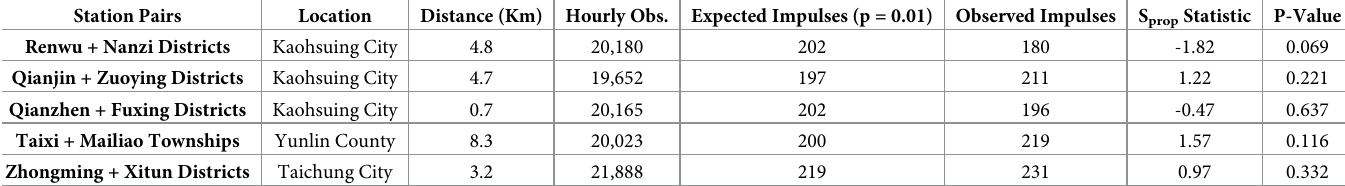
Table 4. Analysis of stations in Taiwan with results generated by applying the IIS methodology to five station pairs. Station